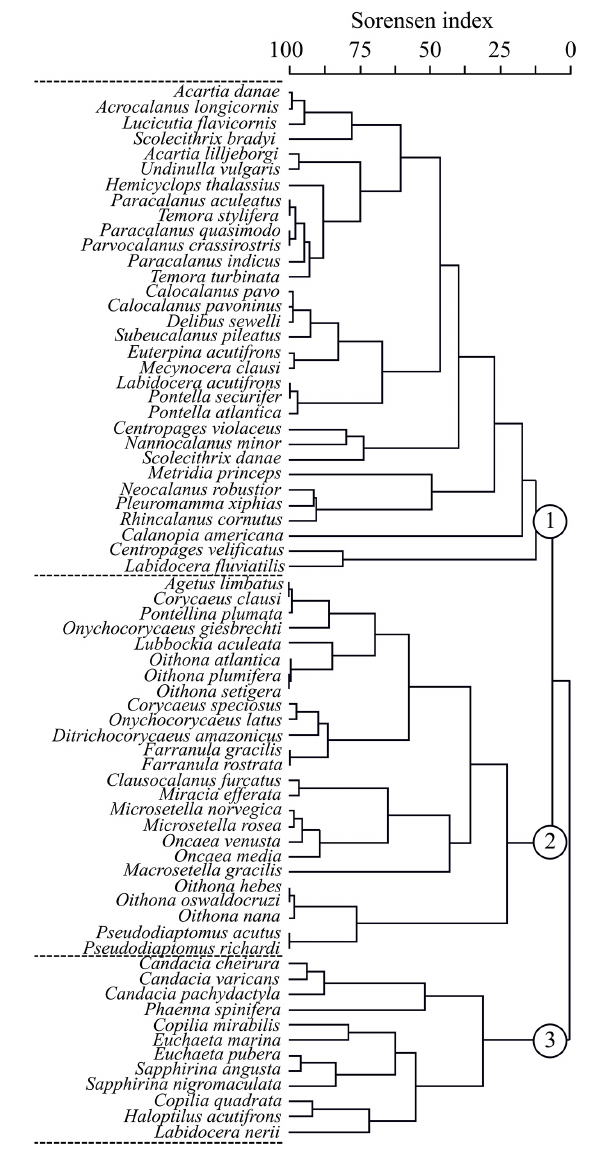
FIGURE 9 | Dendrogram of the Copepoda species that have been clustered by functional traits identified from July 2002 to May 2004 in coastal and oceanic areas off Rio Grande do Norte, Southwestern Atlantic. The numbers 1, 2 and 3 represent the main groups. Sorensen index and average linkage